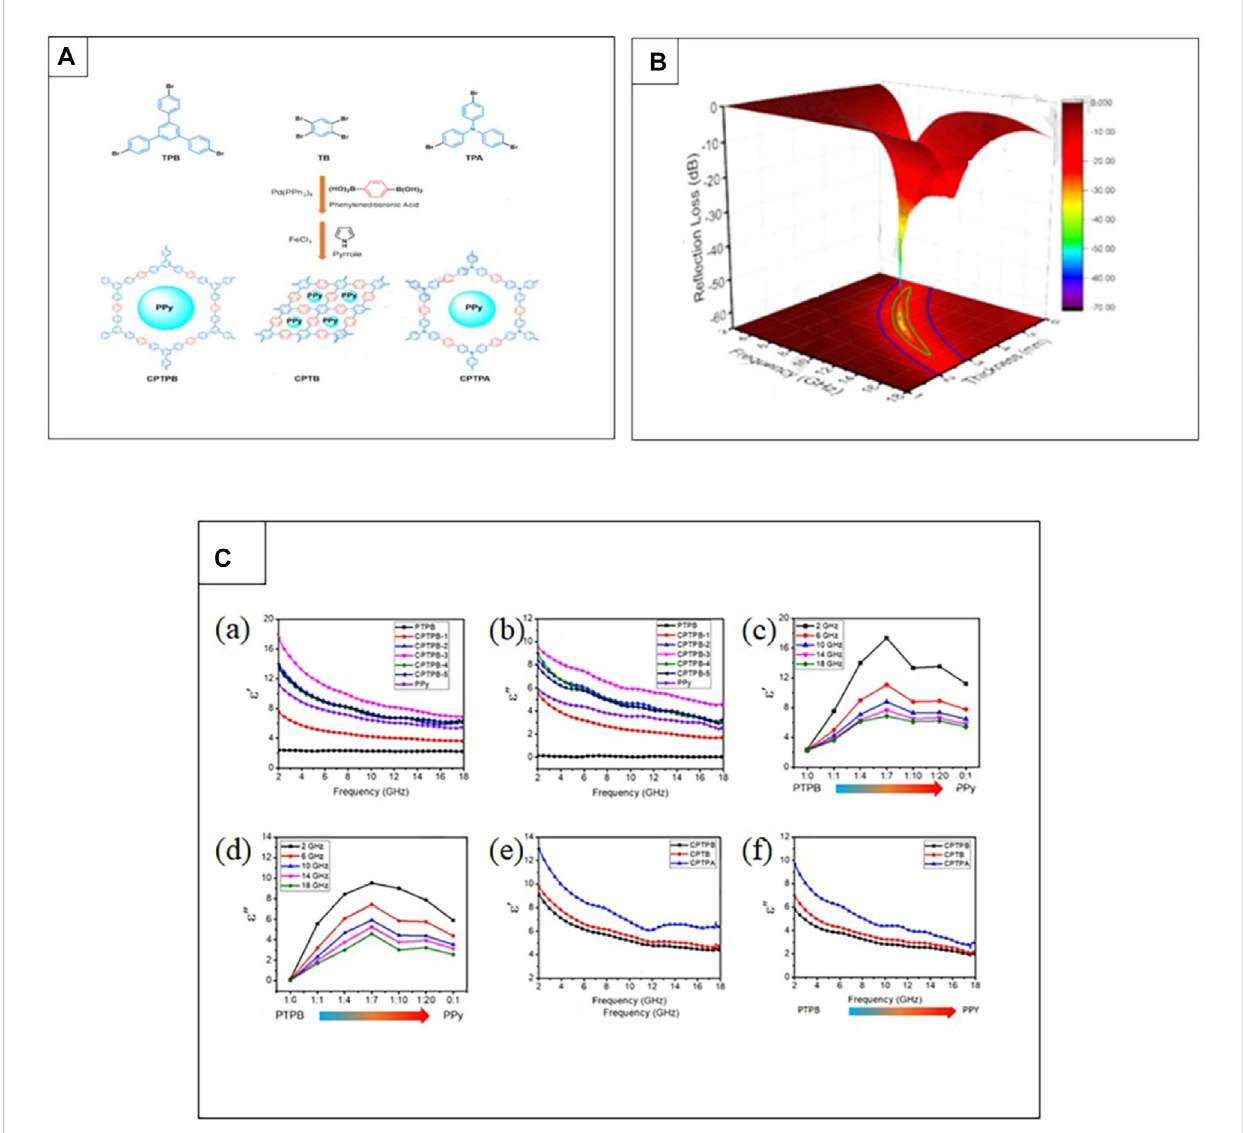
FIGURE 11 (A) Synthetic procedure for conductive CMPs, (B) RL value of the CMPs, and (Ca – f) real ( ε ′ ) and imaginary parts of permittivity ( ε ″ ) of the structures prepared in the diverse routes (Jiao et al.,